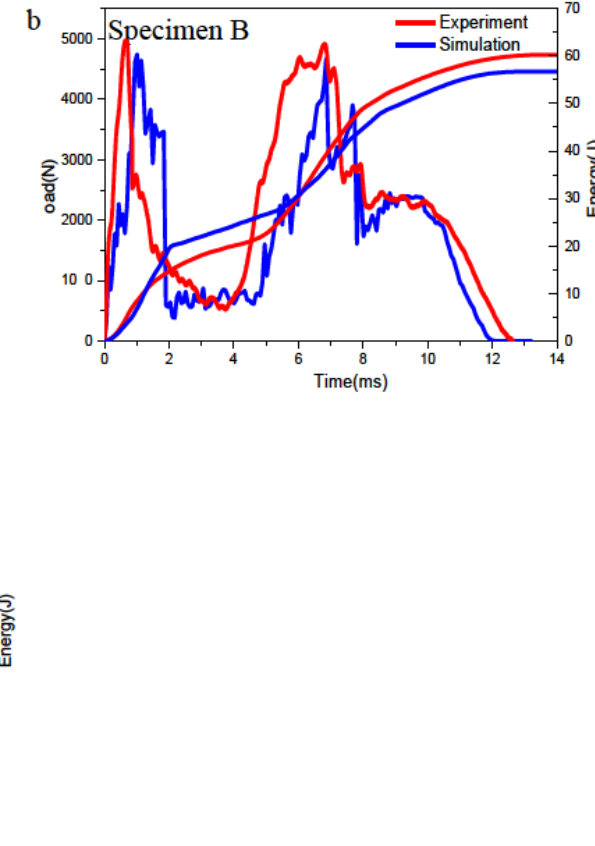
Figure 9: Response of specimens impacted under the impact energy of 60 J.